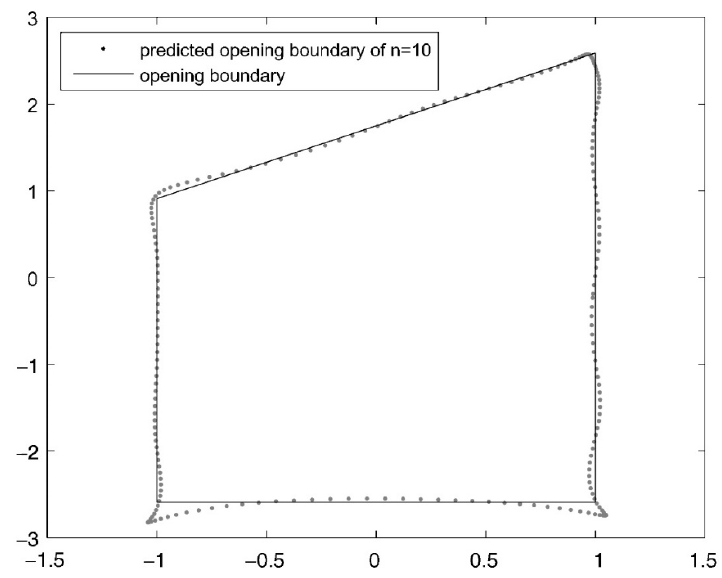
Figure 4. Approximation of the opening boundary of n = 10.